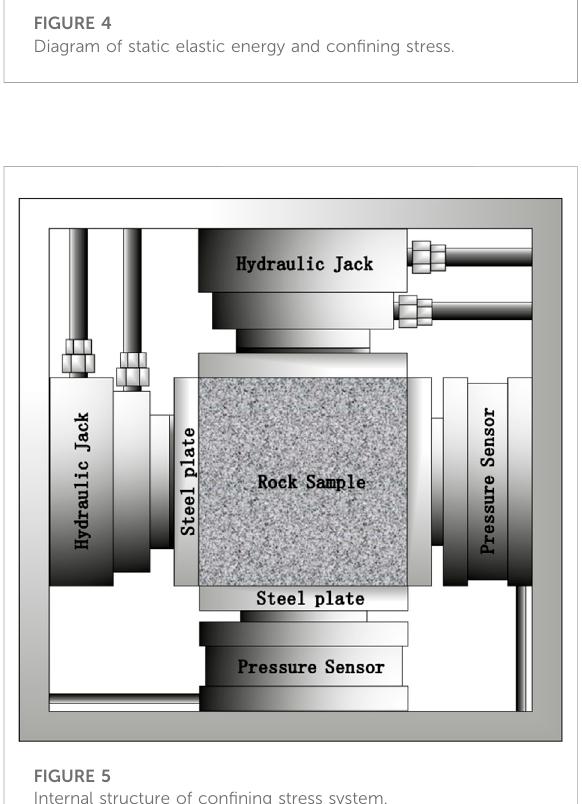
Figure 5. The main technical parameters of the test platform are listed in Table 3.